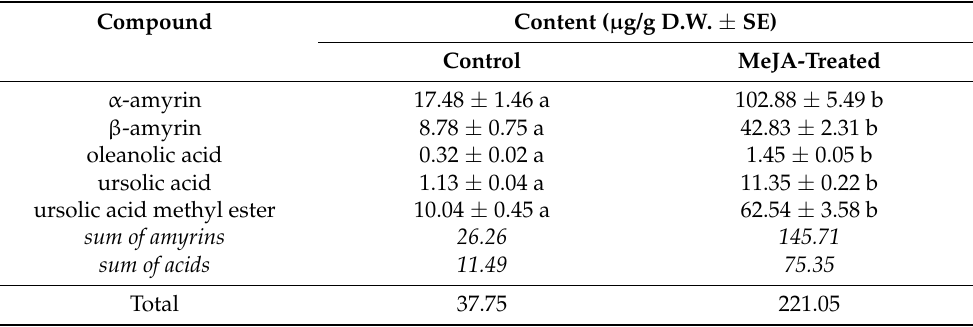
Table 4. The content of triterpenoids in the T. × media ATMA hairy root line after elicitation with 100 µ M MeJA.